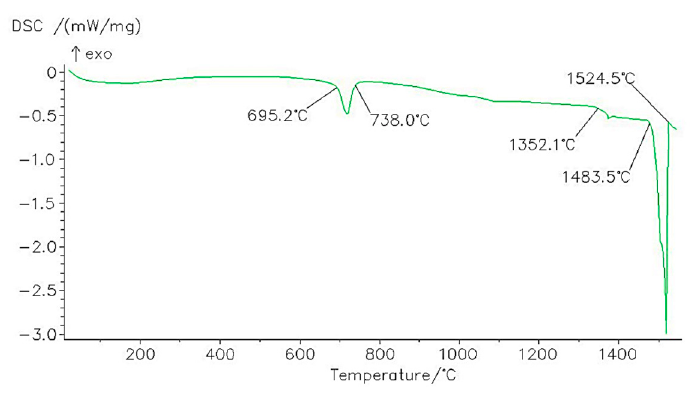
Figure 7. Heating curve of the tooth body steel.